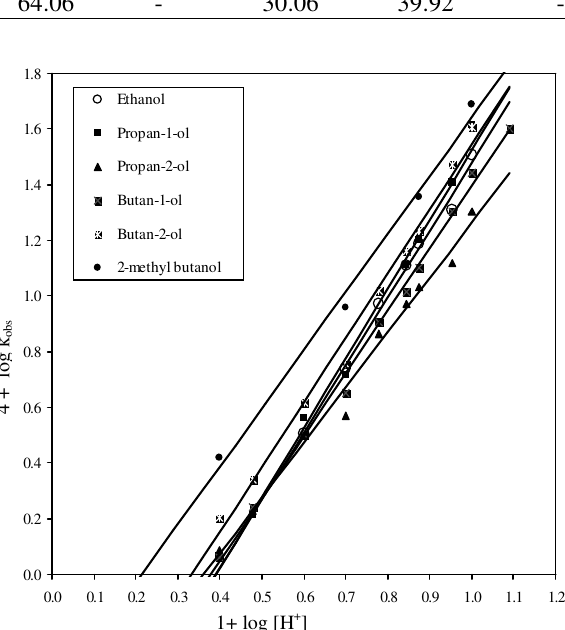
Figure 2. Variation of rate with prechloric acid